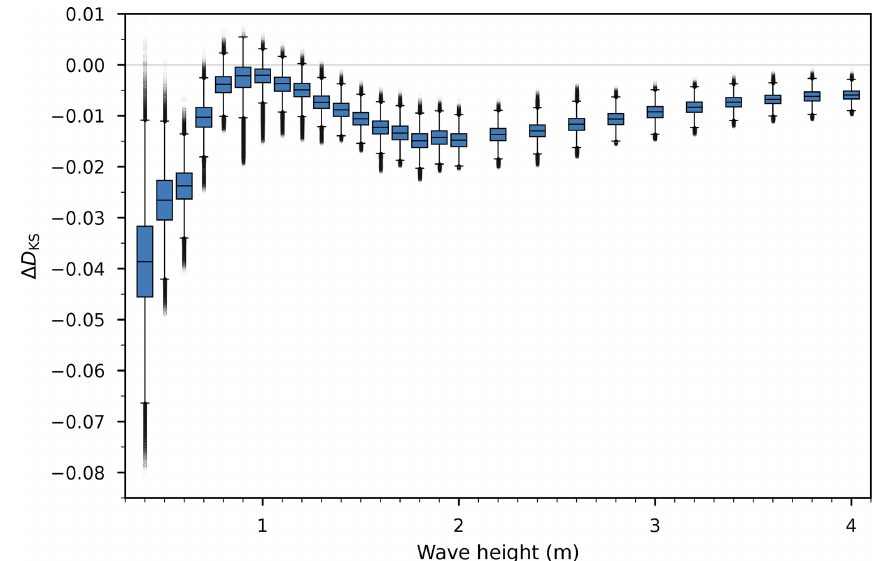
Figure D1. Distribution of (cid:49)D KS , as defined in the text, for varying significant wave height. The boxes are bounded by the first and third quartiles, and the black lines are medians. The whiskers’ lengths are 1.5 times the interquartile range. Black circles represent outliers.